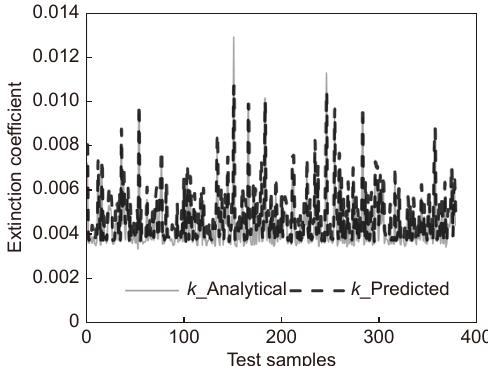
Fig. 14 | Comparison of model-predicted extinction coefficient with analytical values.